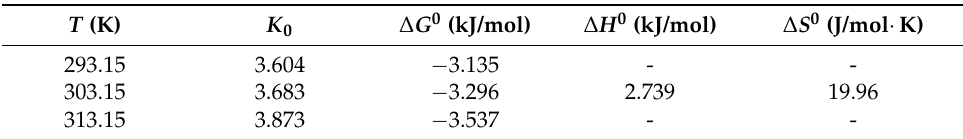
Table 5. Thermodynamics parameters for MV adsorption onto α -Fe 2 O 3 @PHCMs composites with different temperatures.